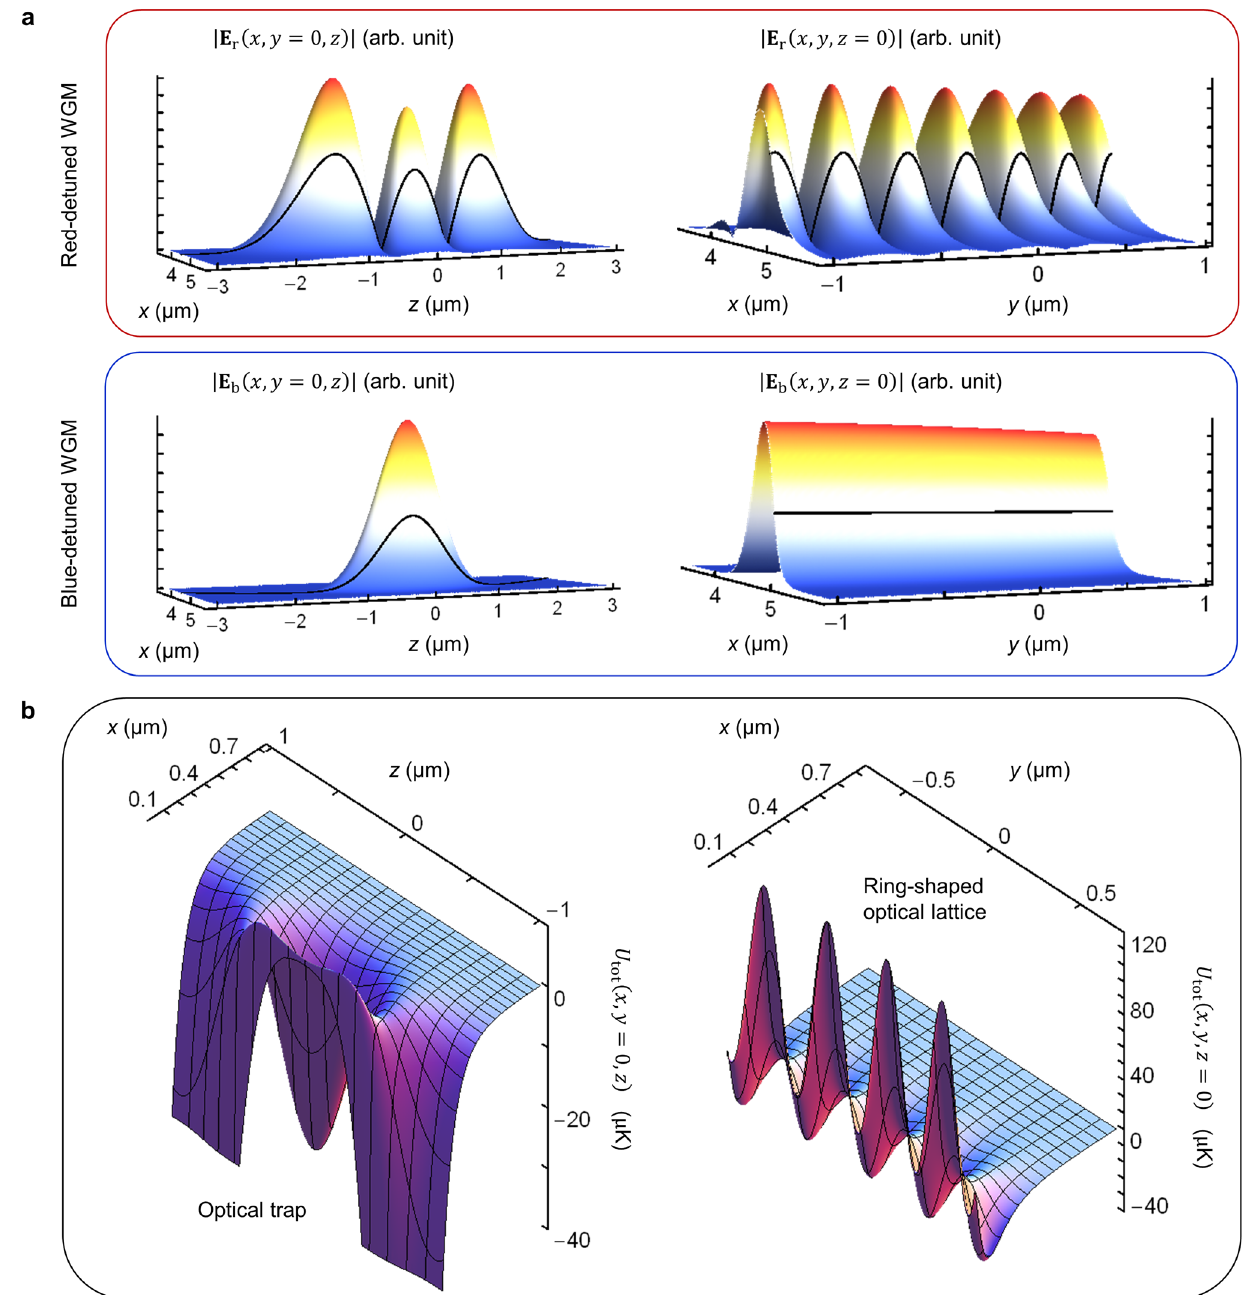
Figure 2. Ring-shaped optical lattice. ( a ) Electric-field distributions of the red-detuned standing-wave ( n r ( n r 1, l r 49, m r 47 ) 1, l r 49, m r ) WGM at the magic wavelength (cid:31) r = = = + = = − 1, l b 109, m b 109 ) WGM at the wavelength (cid:31) b blue-detuned travelling ( n b = = = are TE-polarized. The solid curves correspond to the electric field at the microsphere’s surface. ( b ) Spatial distributions of the total potential U tot (ρ > R , θ , ϕ) . The three-dimensional trapping with a potential depth of 32 µK is achieved by setting the powers of red- and blue-detuned WGM fields at I r respectively. The optical trap presents a ring pattern with 2 m r lattice sites in the x